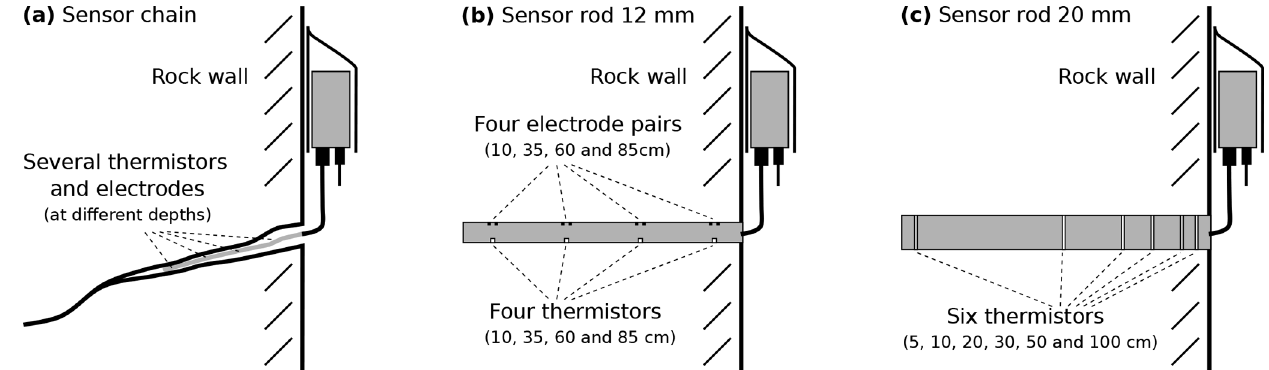
Figure 3. Sensor setup to measure temperature and resistivity in fractures and in rock.